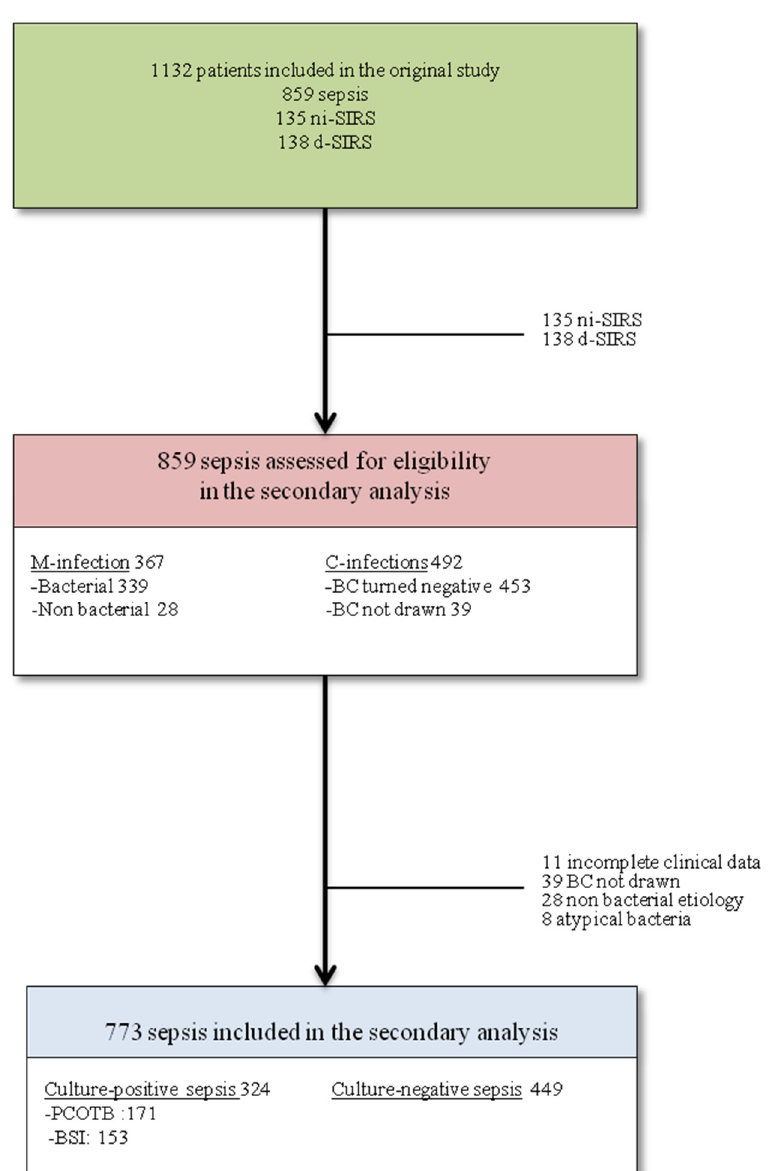
Figure 1. Flow chart of enrollment in this study. List of abbreviations: non infective SIRS = ni-SIRS, d-SIRS = debatable SIRS, M-infections = microbiologically documented infections (definition available in the Supplementary Materials), C-infections = clinically documented infections (definition available in the Supplementary Materials), BC=blood cultures, PCOTB = positive cultures other than